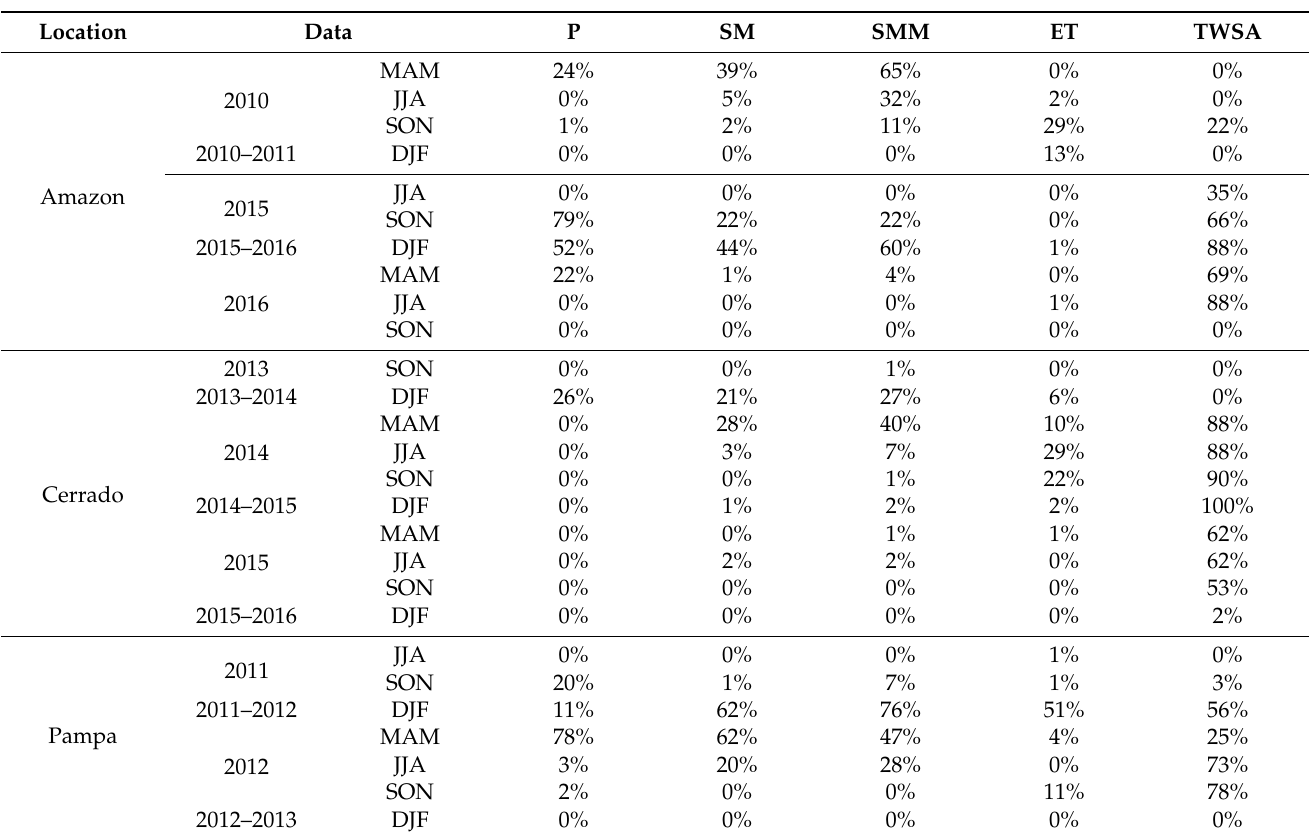
Table 2. Percentage (%) of the polygon area affected by monthly negative anomalous values (z-score ≤ − 1) for precipitation ( P ), surface soil moisture ( SM ), subsurface soil moisture ( SSM ), evapotranspiration ( ET ), and terrestrial water storage anomalies ( TWSA ), for the Amazon, Cerrado, and